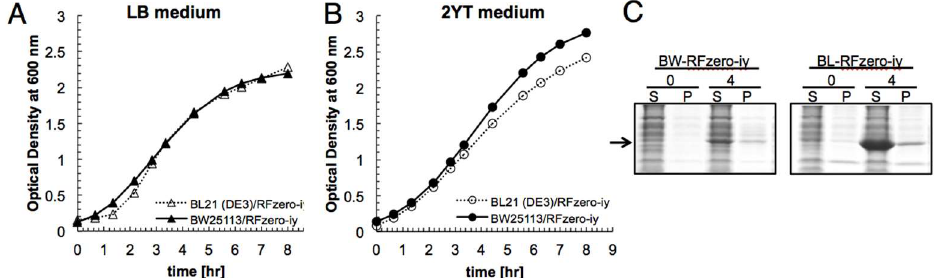
Figure 2. Comparison of RFzero strains derived from E. coli K- and B-strains as sources of S30 cell extracts. The growth profiles of the BW25113- and BL21(DE3)-based RFzero-iy strains in LB ( A ) and 2YT ( B ) at 37 °C, and the cell-free protein synthesis of Chloramphenicol acetyltransferase (CAT) with the S30 extracts from these strains ( C ). Aliquots of the reaction solution from the cell-free protein synthesis were taken at 0 and 4 h, and analyzed by SDS-PAGE with Coomassie Brilliant Blue staining. “S” and “P” indicate the soluble and insoluble fractions, respectively. The arrow indicates the position of CAT.